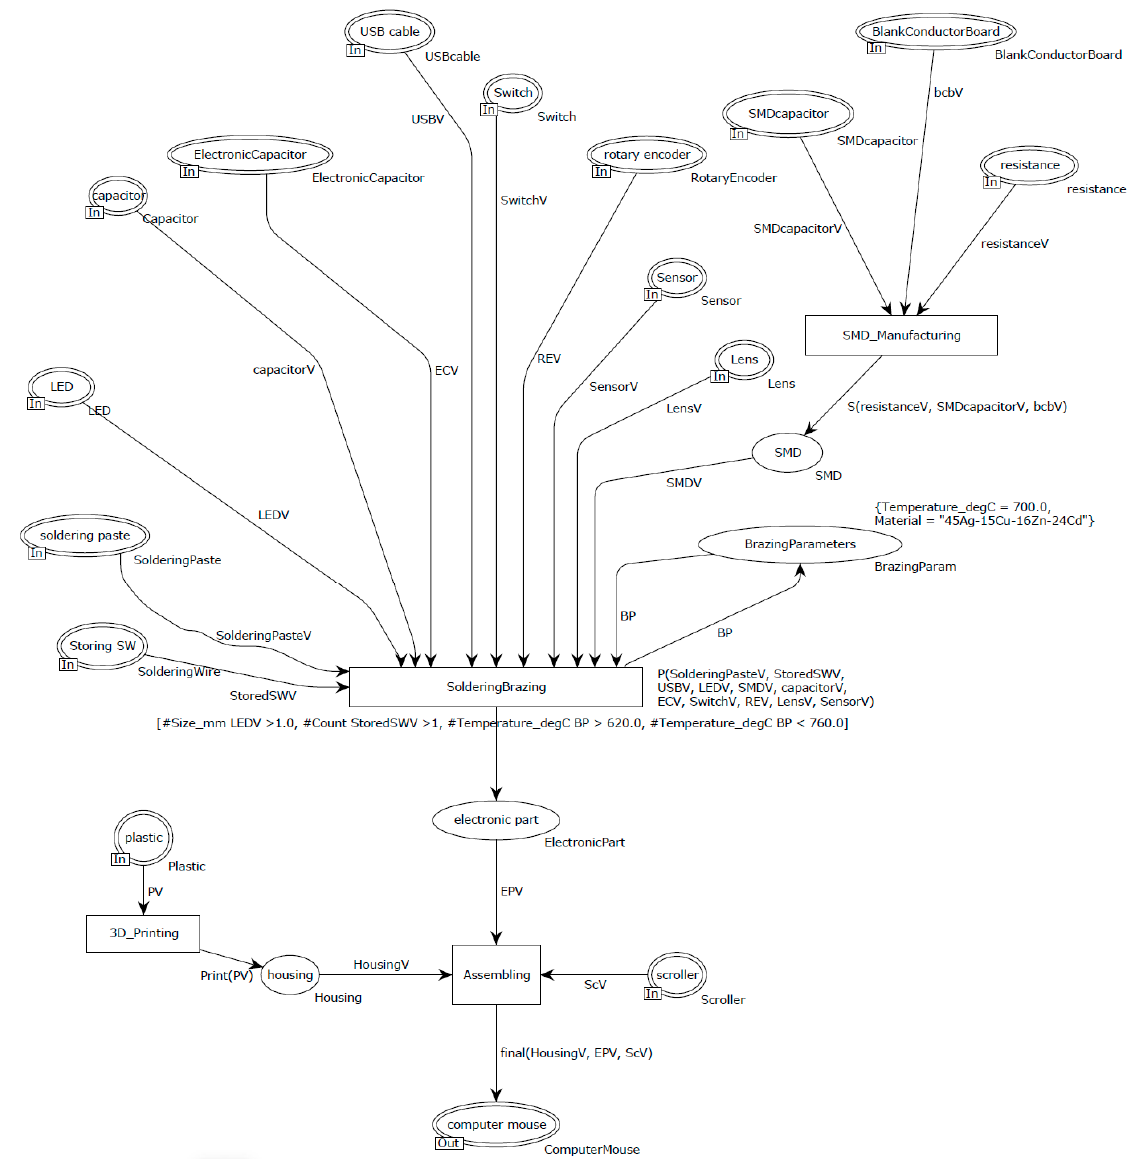
Figure 7. Basic CPN for computer mouse manufacture.